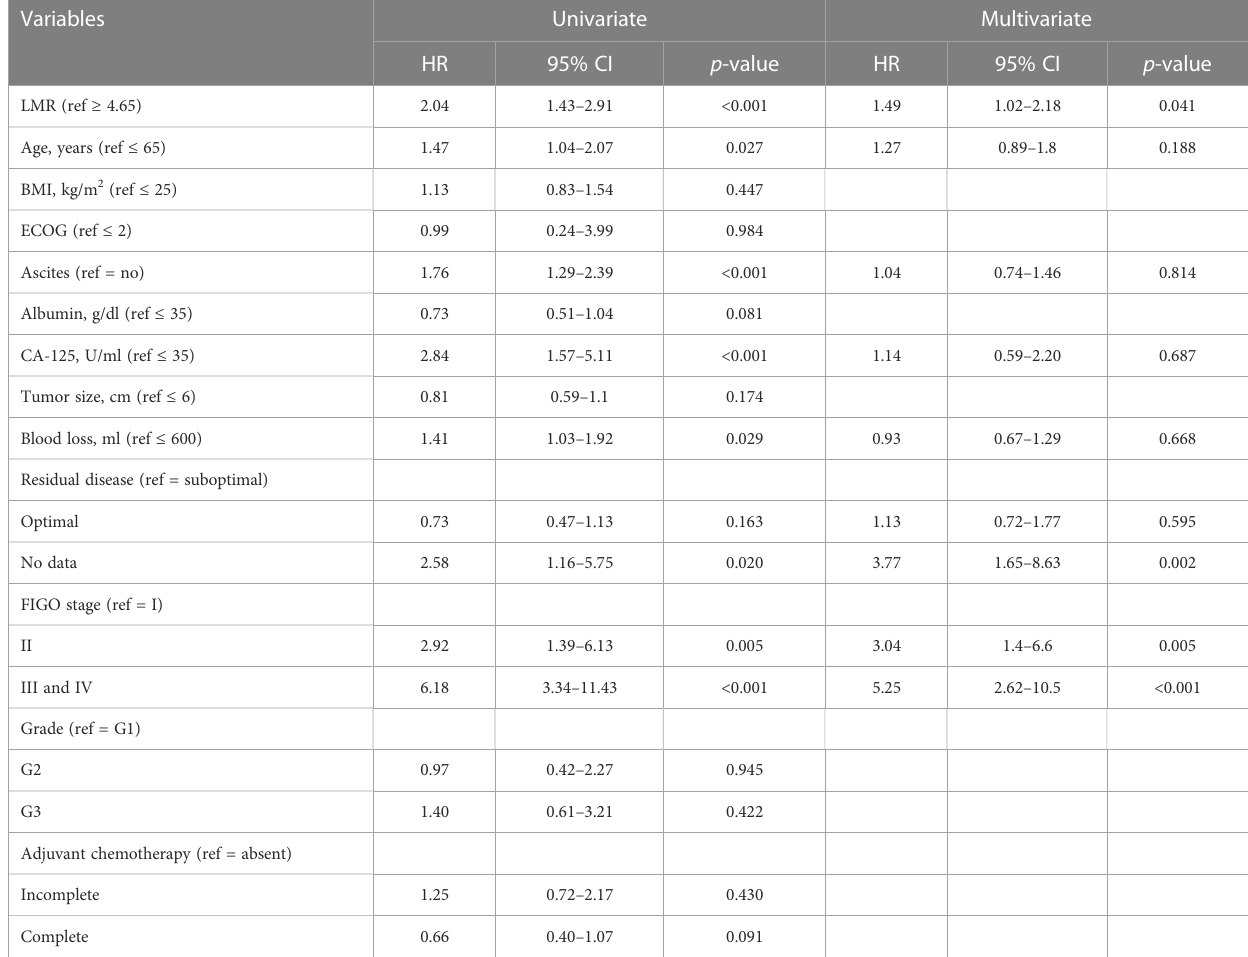
TABLE 2 Univariate and multivariate Cox regression analysis of clinical parameters for overall